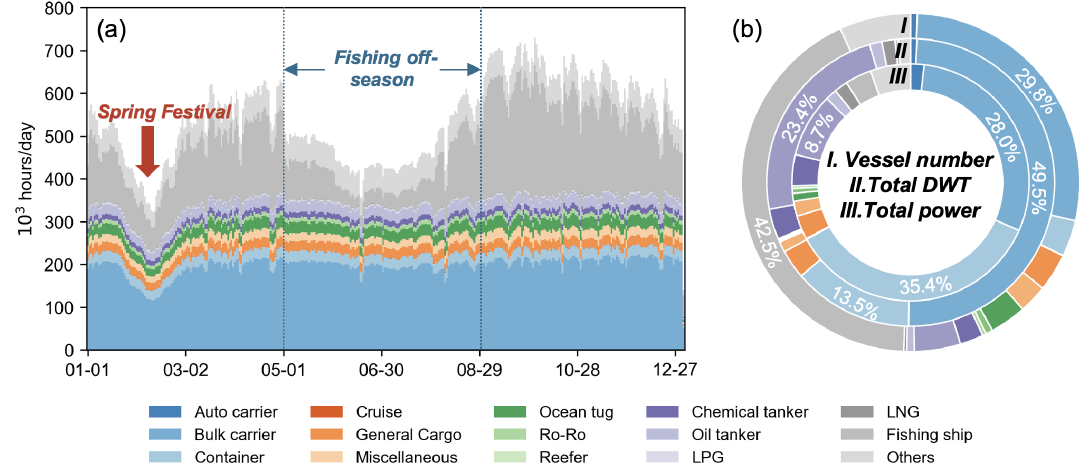
Figure 3. Statistics of vessels’ dynamic and static information for 2016–2019. (a) Daily average operating hours. (b) Vessel fleet compositions from different